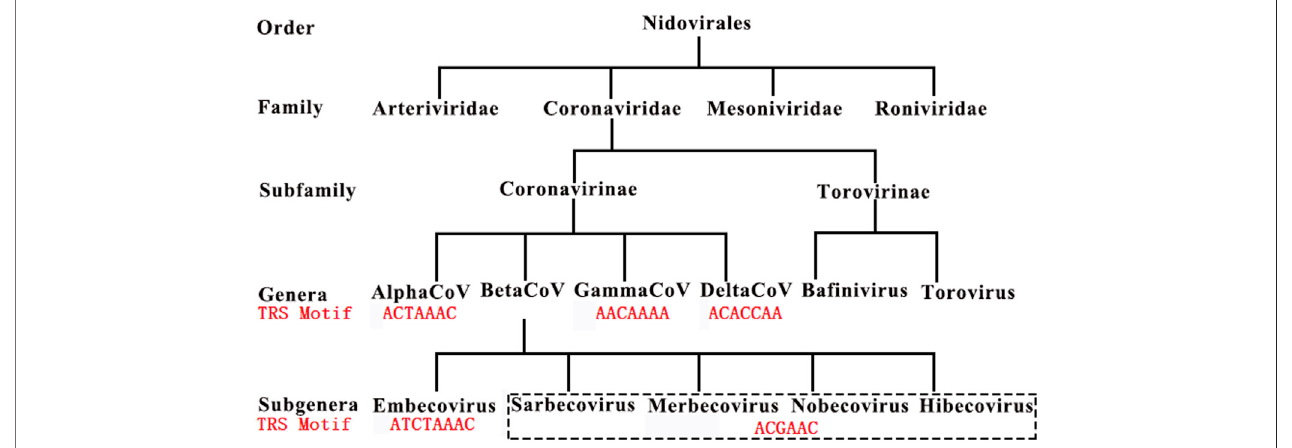
FIGURE1| Canonical TRSmotifsinCoronaviridae. Embecovirus , Sarbecovirus , Merbecovirus , Nobecovirus and Hibecovirus arealso de fi ned as Betacoronavirus subgroups A, B, C, D and E. SARS-CoV and SARS-CoV-2belong to Betacoronavirus subgroup B. Thesecanonical TRS motifs (in red color) of viruses in Coronaviridae have been reported in our previous study (Bei et al.,